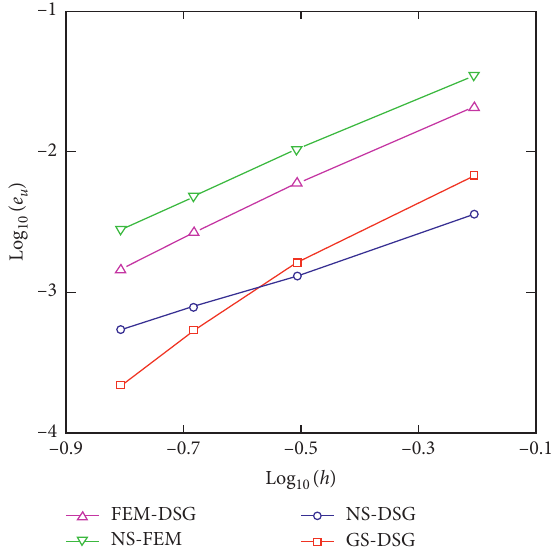
Figure 5: Convergence